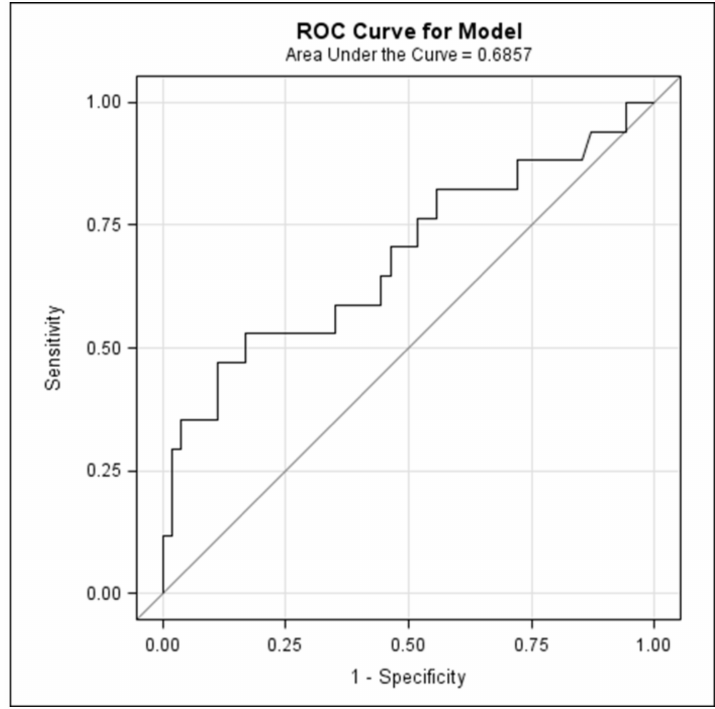
Figure 2. Receiver operating characteristic (ROC) curve of omega-3 index cut-o ff s as a prediction for postpartum